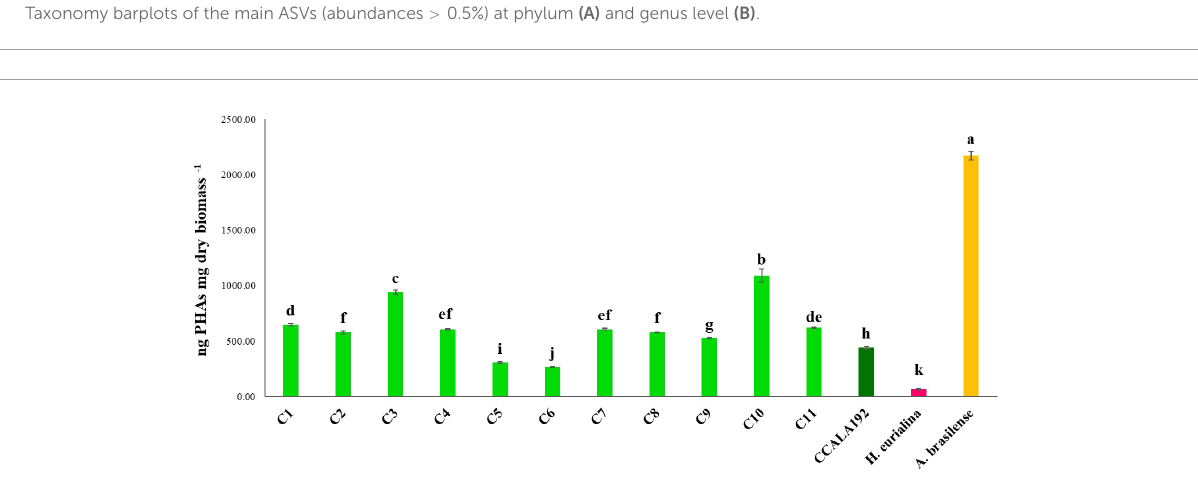
FIGURE3 Polyhydroxyalkanoates contents recorded for “Stiffe” caves’ cyanobacteria and Synechocystis cf. salina , grown in BG11 0 , and for A. brasilense and H. eurihalina , cultured on NFCC and MH, respectively. Uppercase letters refer to the comparison among BG11 0 growths and A. brasilense and H. eurihalina. Lowercase letters refer to the comparison among BG11 starving growths and A. brasilense and H. eurihalina. For both conditions, results followed by the same case letters are not significantly different according to Fisher’s LSD post hoc test ( p > 0.05) (LSD value,